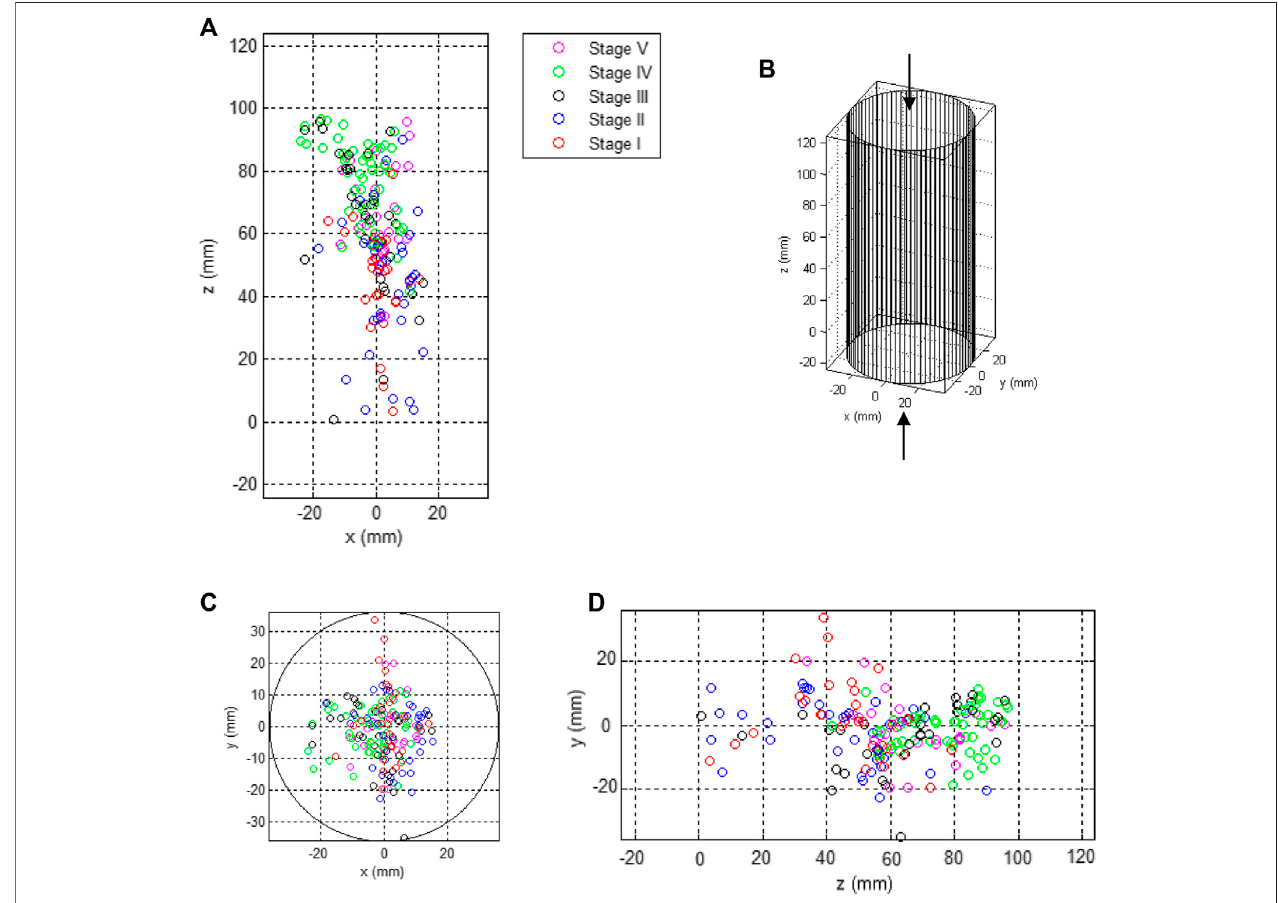
FIGURE10| CumulativeAEsourcelocationsoftheuniaxialcompressiontest: (A) projectfrontviewofsample, (B) sampleorientationindicatingdirectionofapplied load, (C) top view of sample, and (D) side view.